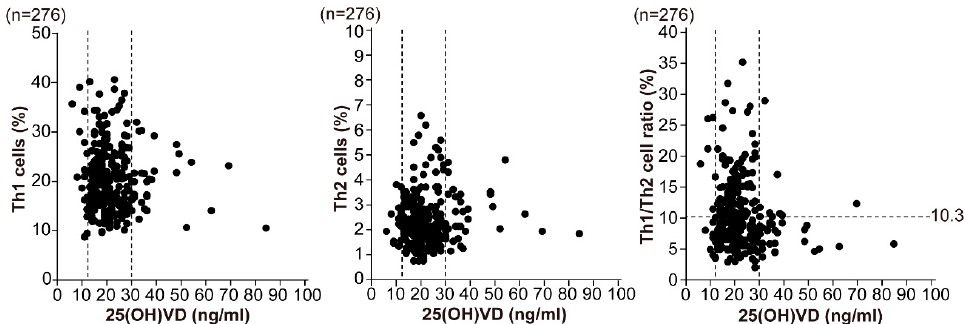
Figure 1. Relationship between serum 25(OH)VD and T-helper (Th) cells in infertile patients. The data demonstrated the relationships between 25(OH)VD and the Th1 and Th2 cell populations, and the Th1/Th2 cell ratio. All data were divided into three groups that were categorized as vitamin D deficiency, insufficiency, and sufficiency (25[OH]VD < 12, 12–30, and > 30 ng/mL respectively; dotted lines ). Regarding the Th1 (CD4 + /interferon [IFN]- γ + )/Th2 (CD4 + /interleukin[IL]-4 + ) cell ratio, the normal range is <10.3 ( dotted lines ). Analysis of data from 276 general infertile patients showed a higher Th1/Th2 cell ratio in the VD-deficient and insufficient groups, but no correlation between serum 25(OH)VD and Th1 or Th2 cells or Th1/Th2 cell ratio. 25(OH)VD, 25-hydroxy vitamin D3; Th1 cell, IFN- γ –producing T-helper cell (CD4 + /IFN- γ + ); Th2 cell, IL-4–producing T-helper cell (CD4 + /IL-4 + ).